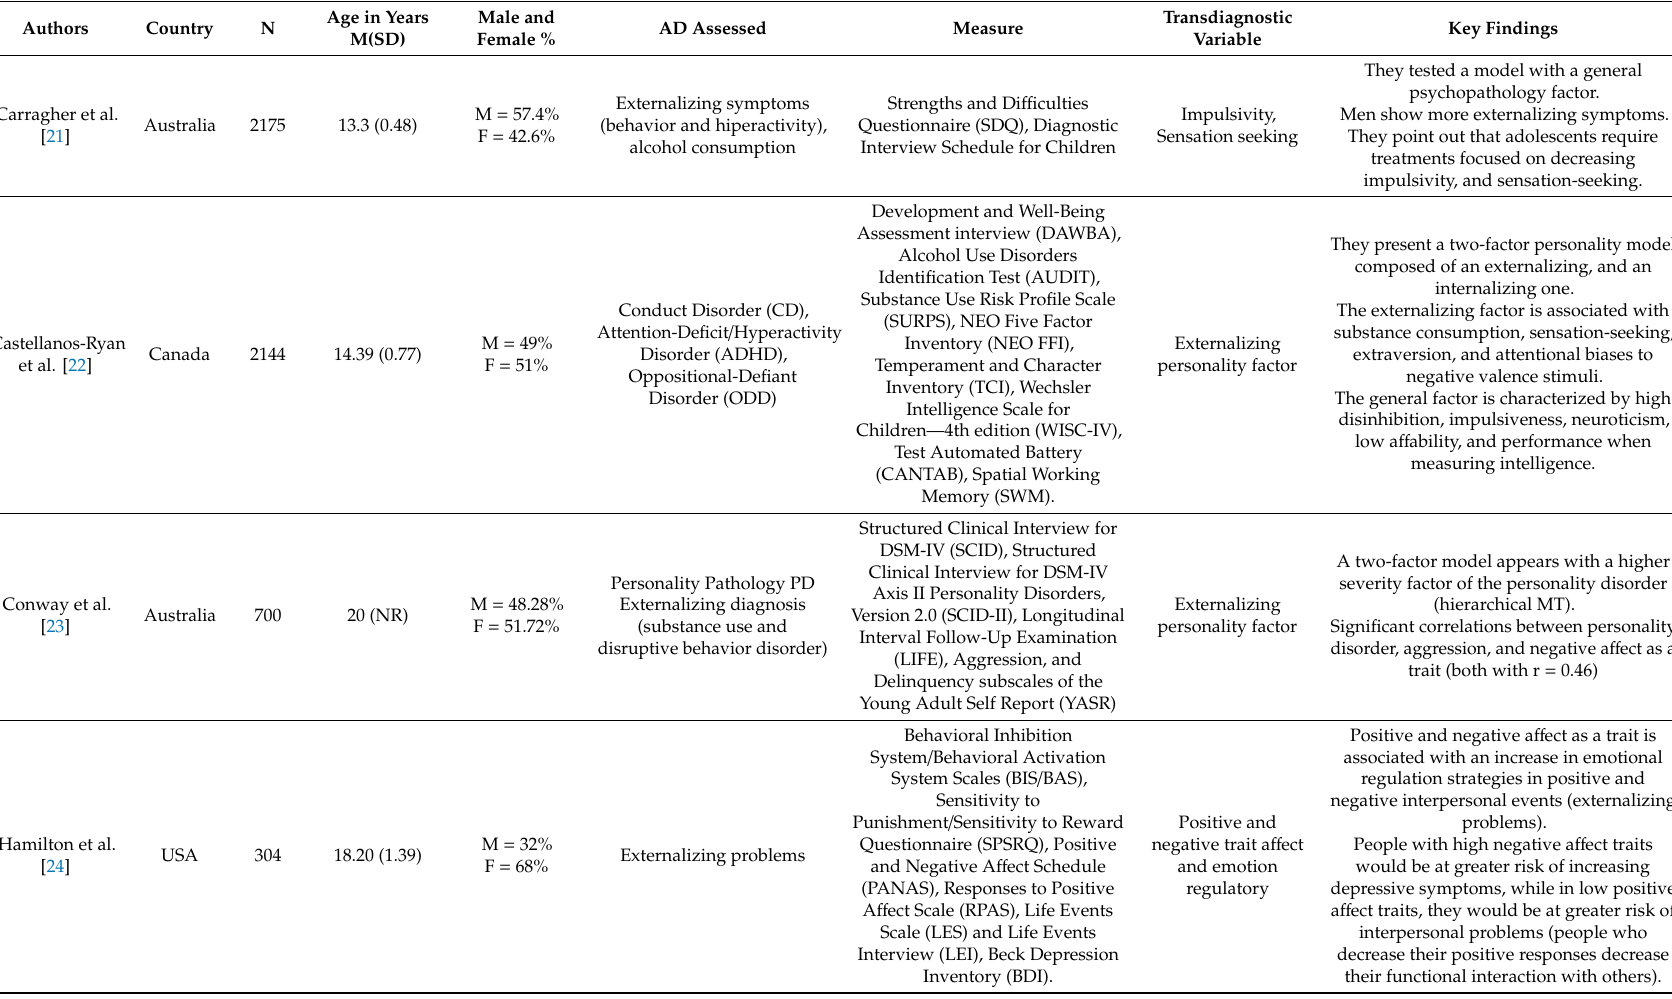
Table 2. Summary of reviewed empirical studies including, transdiagnostic variables in antisocial disorders at the structural